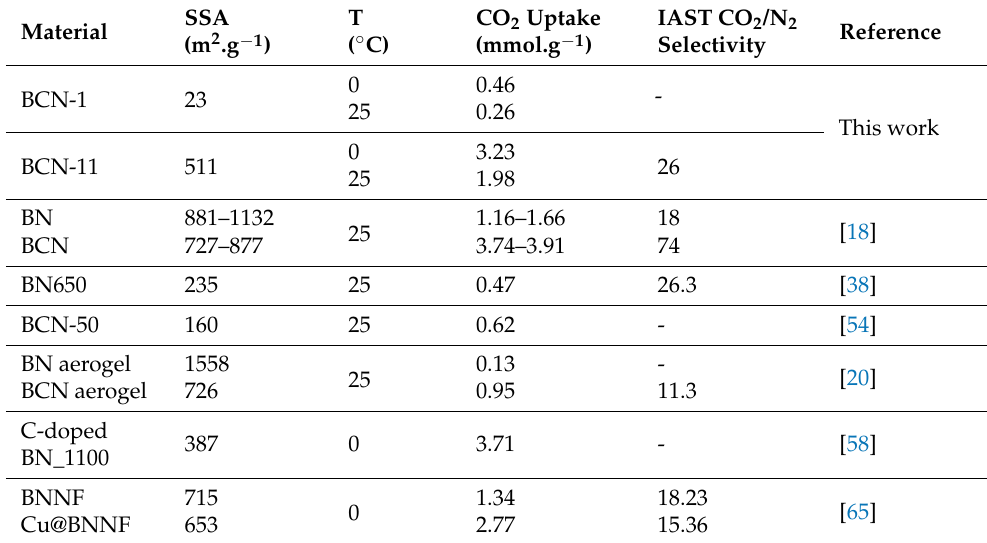
Table 4. Comparison of CO 2 uptake and selectivity of several BN-based porous adsorbents.